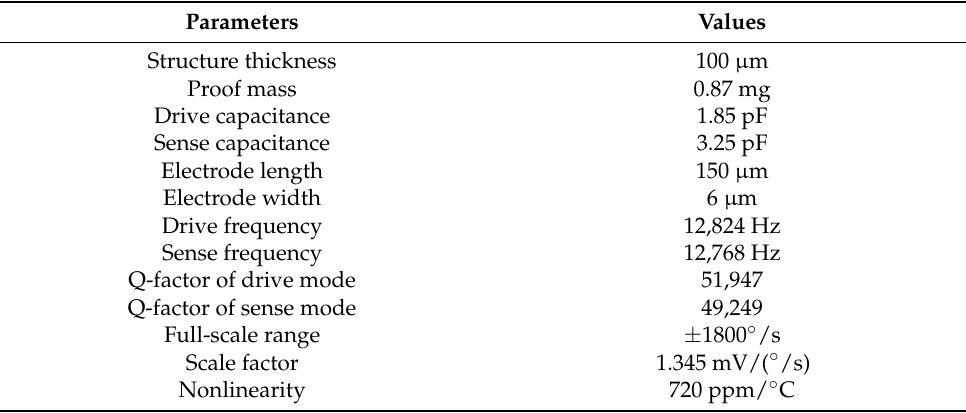
Table 1. Key parameters of the dual-mass TFGs.